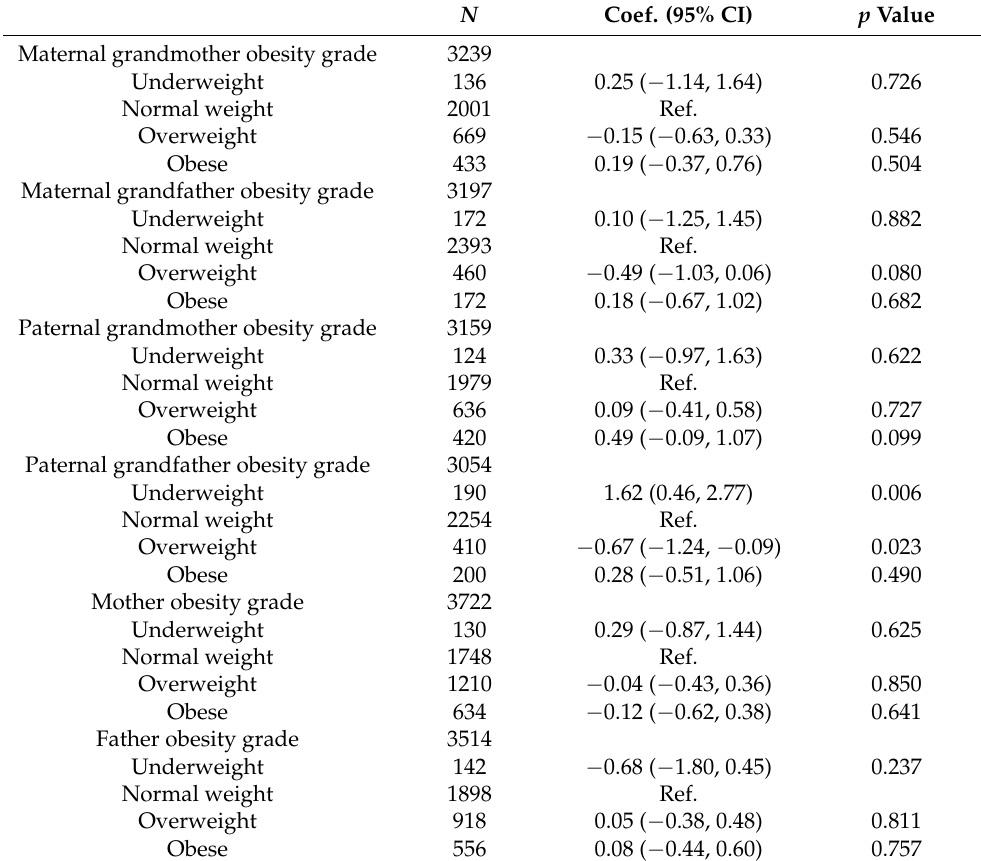
Table 2. Adjusted associations between intergenerational obesity grade and total weight loss (kilo- grams) in adulthood, in response to a dietary intervention. N Coef. (95%